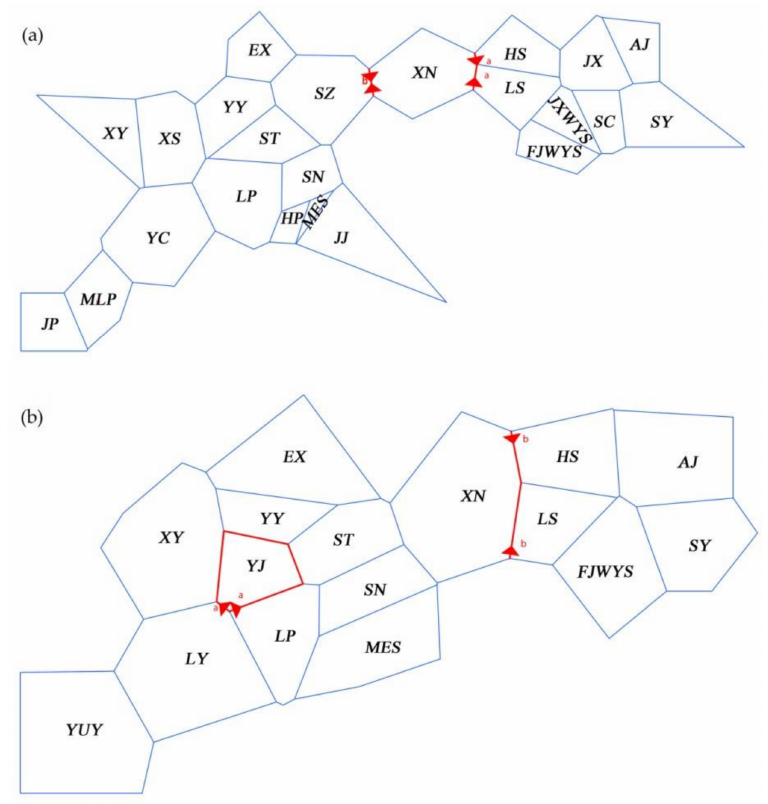
Figure 3. The first two genetic barriers in L. chinense projected by Barrier 2.2. ( a ) The first two genetic barriers in L. chinense based on cpDNA. ( b ) The first two genetic barriers in L. chinense based on five nuclear genes. The red lines with two opposite arrows indicate the barriers ( a , b ). The black letters represent the abbreviated names of sample